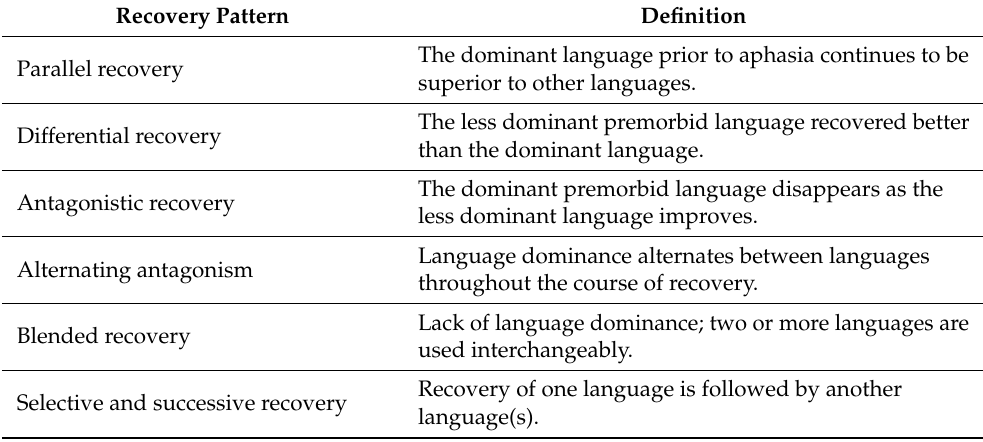
Table 1. Recovery patterns of languages among bilingual PWA. Adapted from Paradis (2001). Recovery